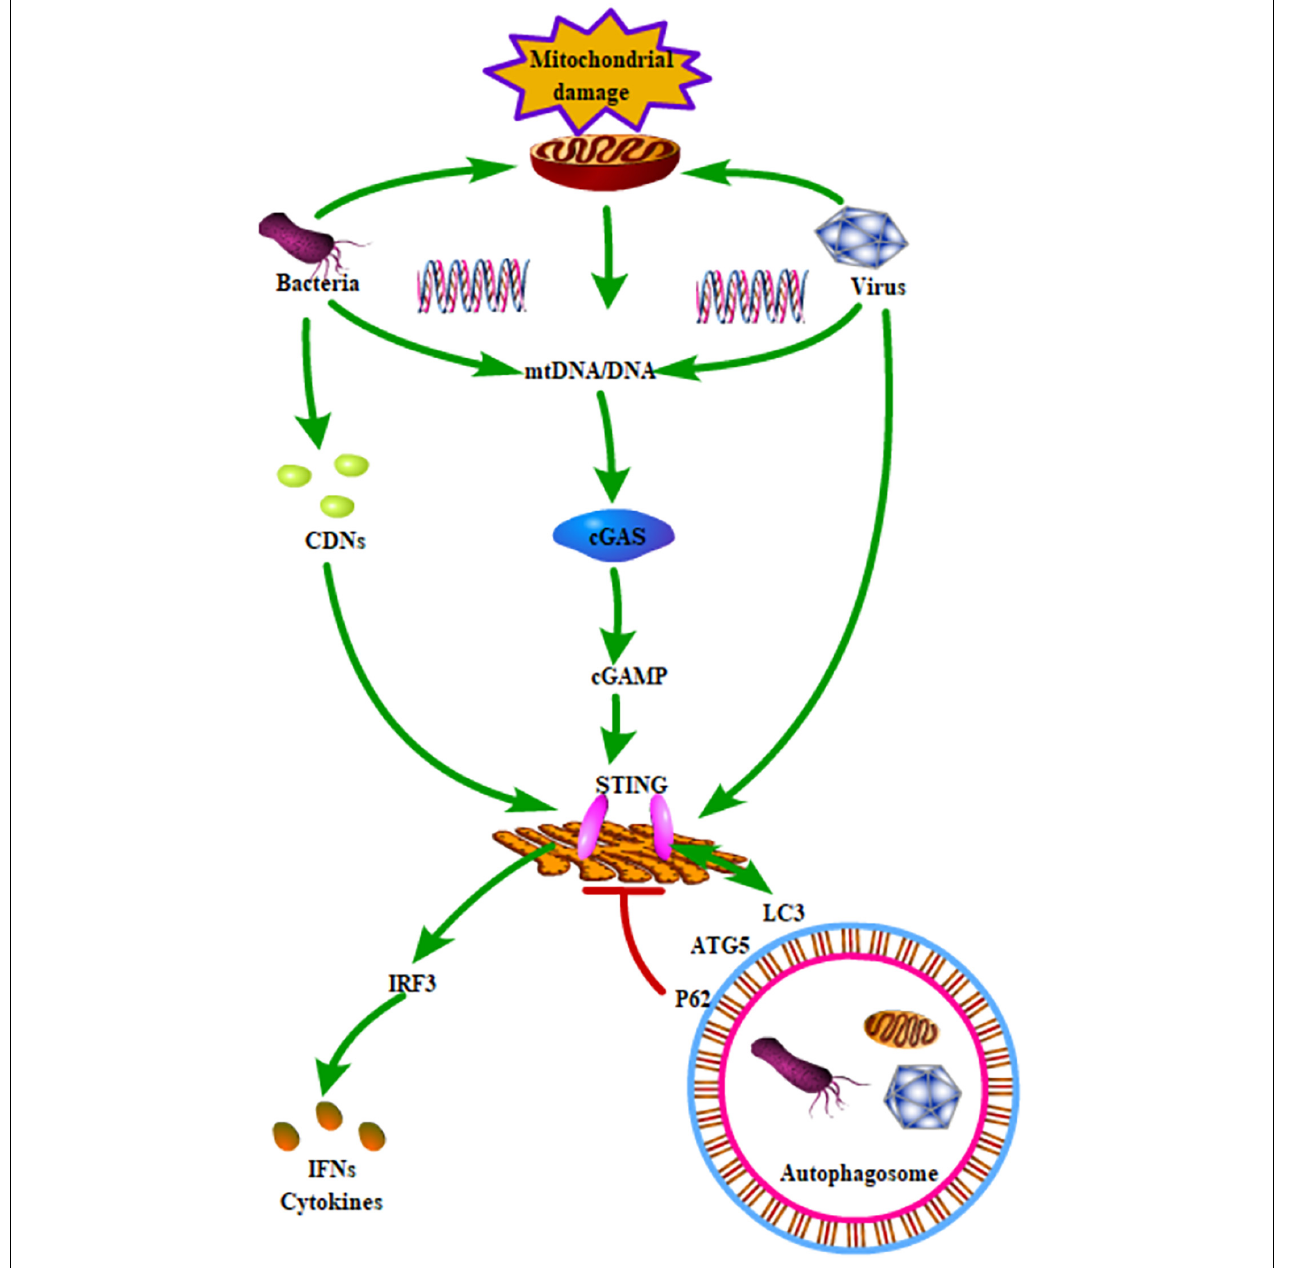
FIGURE 1 | Schematic role of STING signaling in autophagy and mitochondrial homeostasis. STING could be activated by all kinds of pathogenic microorganisms and mtDNA. The activated STING could induce the production of IFNs and cytokines through phosphorylation of IRF3. In addition, STING directly interacted with LC3 and further activated ATG5-dependent autophagy. Moreover, P62, which is a key receptor for regulating autophagy, could degrade